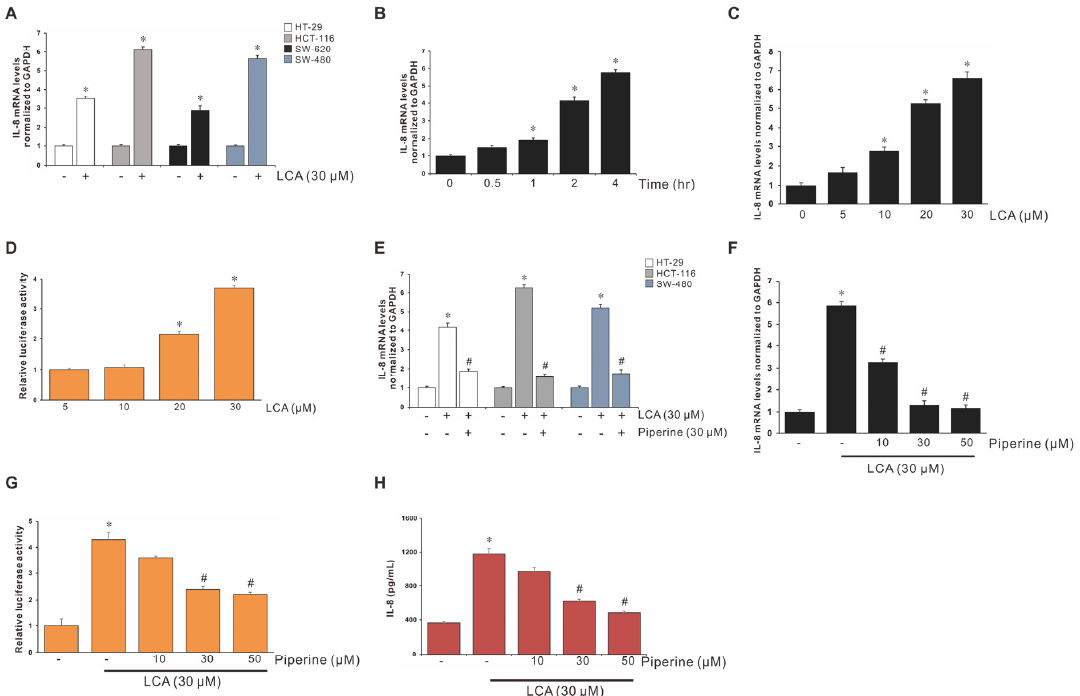
Figure 1. Piperine Inhibits LCA-Induced IL-8 Expression in HCT-116 Cells. ( A ) Four different human CRC cell lines were incubated with 30 μ M lithocholic acid (LCA) for 4 h, followed by mRNA extraction and RT-qPCR, to determine IL-8 expression level. HCT-116 cells were incubated with 30 μΜ LCA for 0–4 h ( B ) or with 0–30 μ M LCA for 4 h ( C ). ( D ) HCT-116 cells were transiently transfected with 500 ng pGL2-IL-8 promoter–reporter construct. These transfected cells were incubated with 30 μΜ LCA in a dose-dependent manner for 4 h, and the luciferase activity was measured using a luminometer. ( E ) Three different human CRC cell lines were pretreated with 30 μΜ piperine and incubated with 30 μΜ LCA for 4 h, followed by mRNA extraction and RT-qPCR to determine IL-8 expression level. ( F ) HCT-116 cells were pretreated with piperine (10, 30, and 50 μΜ ) and incubated with 30 μΜ LCA for 4 h, followed by mRNA extraction and RT-qPCR to determine IL-8 expression level. ( G ) HCT-116 cells were transiently transfected with 500 ng pGL2-IL-8 promoter–reporter construct. These transfected cells were pretreated with piperine (10, 30, and 50 μΜ ) and incubated with 30 μΜ LCA for 4 h, and the luciferase activity was measured using a luminometer. ( H ) HCT-116 cells were pretreated with piperine (10, 30, and 50 μΜ ) and incubated with 30 μΜ LCA for 24 h, followed by ELISA assay to determine the IL-8 secretion level. Data represent the mean ± standard error of the mean (SEM) from three experimental trials. * p < 0.05 versus control; # p < 0.05 versus LCA.